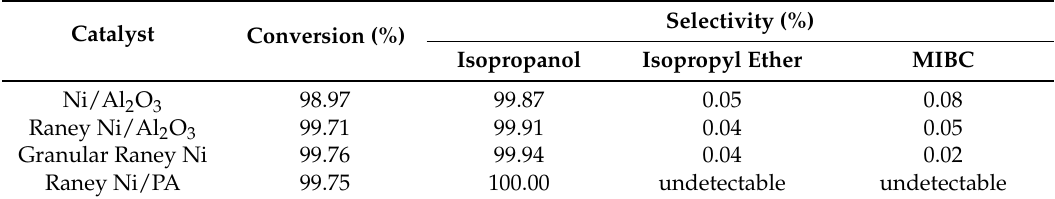
Table 3. Hydrogenation of acetone with different catalysts at 132 °C [18]. Reproduced with permission from Jiang H., Sci. China Chem.; published by Springer, 2016.